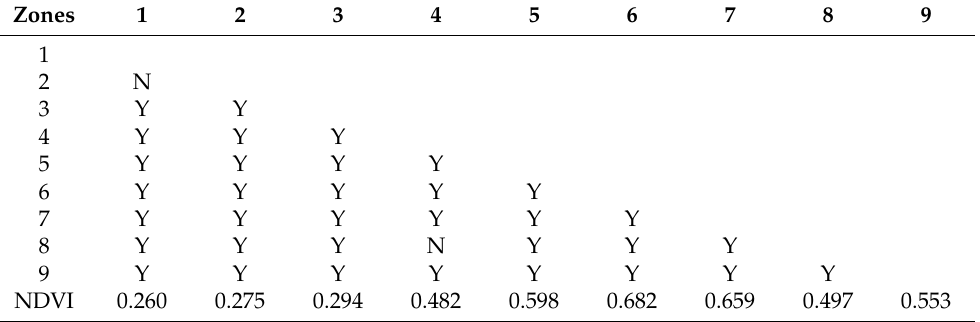
Table 10. Mean NDVI value and significant differences in the annual average temperature between two